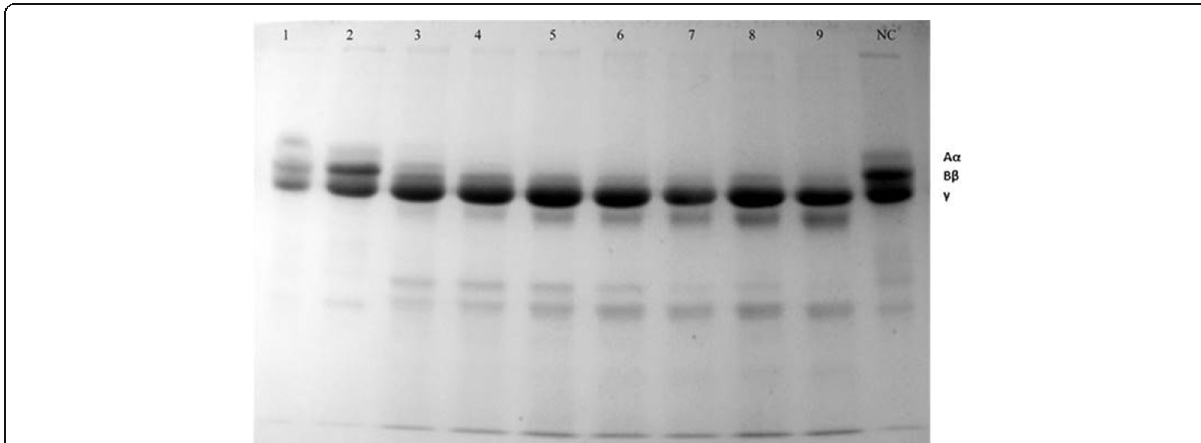
Fig. 3 Dose-dependent fibrinogenolysis by SCF. Varying dosages of SCF were incubated with fibrinogen as substrate. Numbers on each lane indicate the concentration of SCF (in μ g/ml) incubated with 15 μ l of 2 mg/ml of fibrinogen at 37 °C for 5 h. NC is negative control (fibrinogen incubated with KPB)